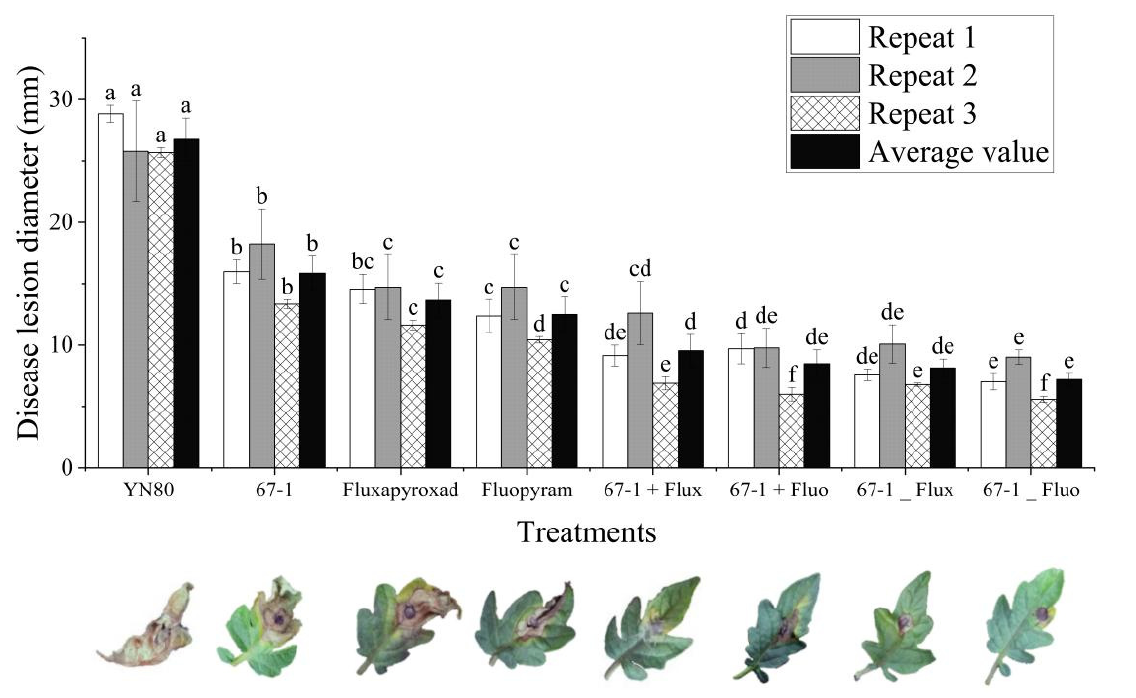
Figure 3. The disease lesion diameter of tomato gray mold when treated by Clonostachys rosea 67-1, fluxapyroxad, fluopimomide alone, in combination, or in rotation. Data are presented as the mean ± standard deviation (SD). The different lowercase letters indicate significant differences between different treatments in each repeat at the 5% level of probability. “YN80”, only inoculated with mycelial plugs of B. cinerea isolate YN80; “67-1”, sprayed with conidia suspension of C. rosea isolate 67-1; “Fluxapyroxad”, sprayed with fluxapyroxad; “Fluopyram”, sprayed with fluopyram; “67-1+Flux”, sprayed with the mixture of 67-1 conidia suspension and fluxapyroxad; “67-1+Fluo” sprayed with the mixture of 67-1 conidia suspension and fluopyram; “67-1_Flux”, sprayed the 67-1 conidia suspension first and fluxapyroxad 24 h later; “67-1_Fluo” sprayed the 67-1 conidia suspension first and fluxapyroxad 24 h later.